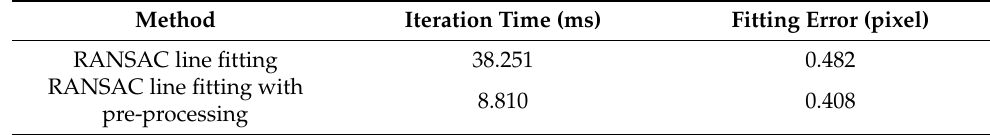
Figure 14. Flow chart of RANSAC linear fitting based on pre-processing. Table 6. The iteration time and fitting error results.